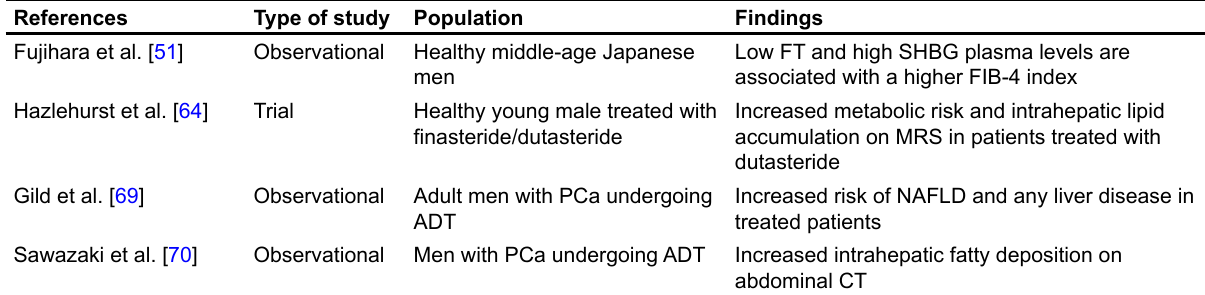
Table 2. Summary of the studies evaluating the role of sex hormones in the risk of NAFLD ( continued